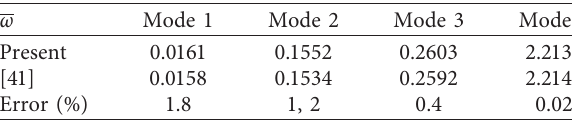
Table 3: Nondimensional frequency ω